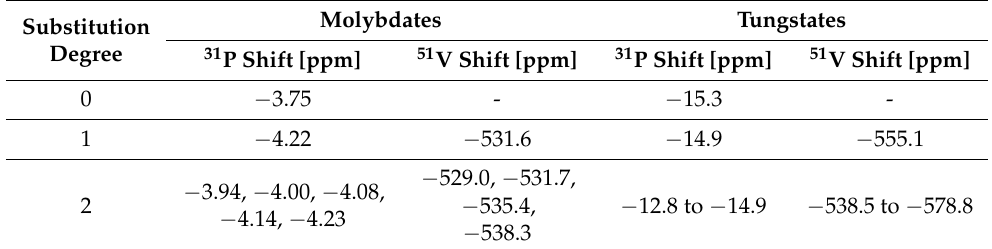
Table 4. 31 P and 51 V chemical shifts of the POMs investigated in this